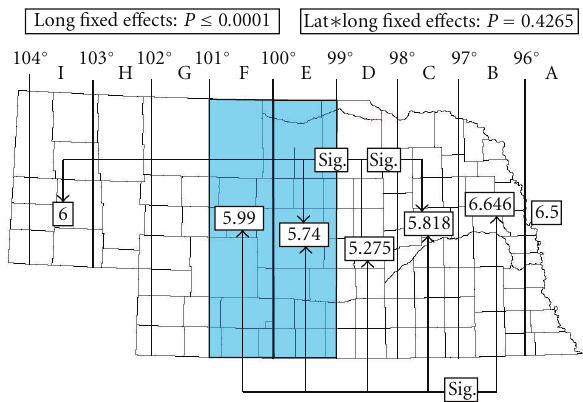
Figure 6: Mean elytral color by code for Cicindela limbalis by lon- gitudinal region. Significant di ff erences between longitudes shown by arrows and mean value presented in each longitudinal grouping. Fixed e ff ects presented at top. No latitude by longitude interactions found. Shaded area depicts longitudinal regions di ff ering from all others.